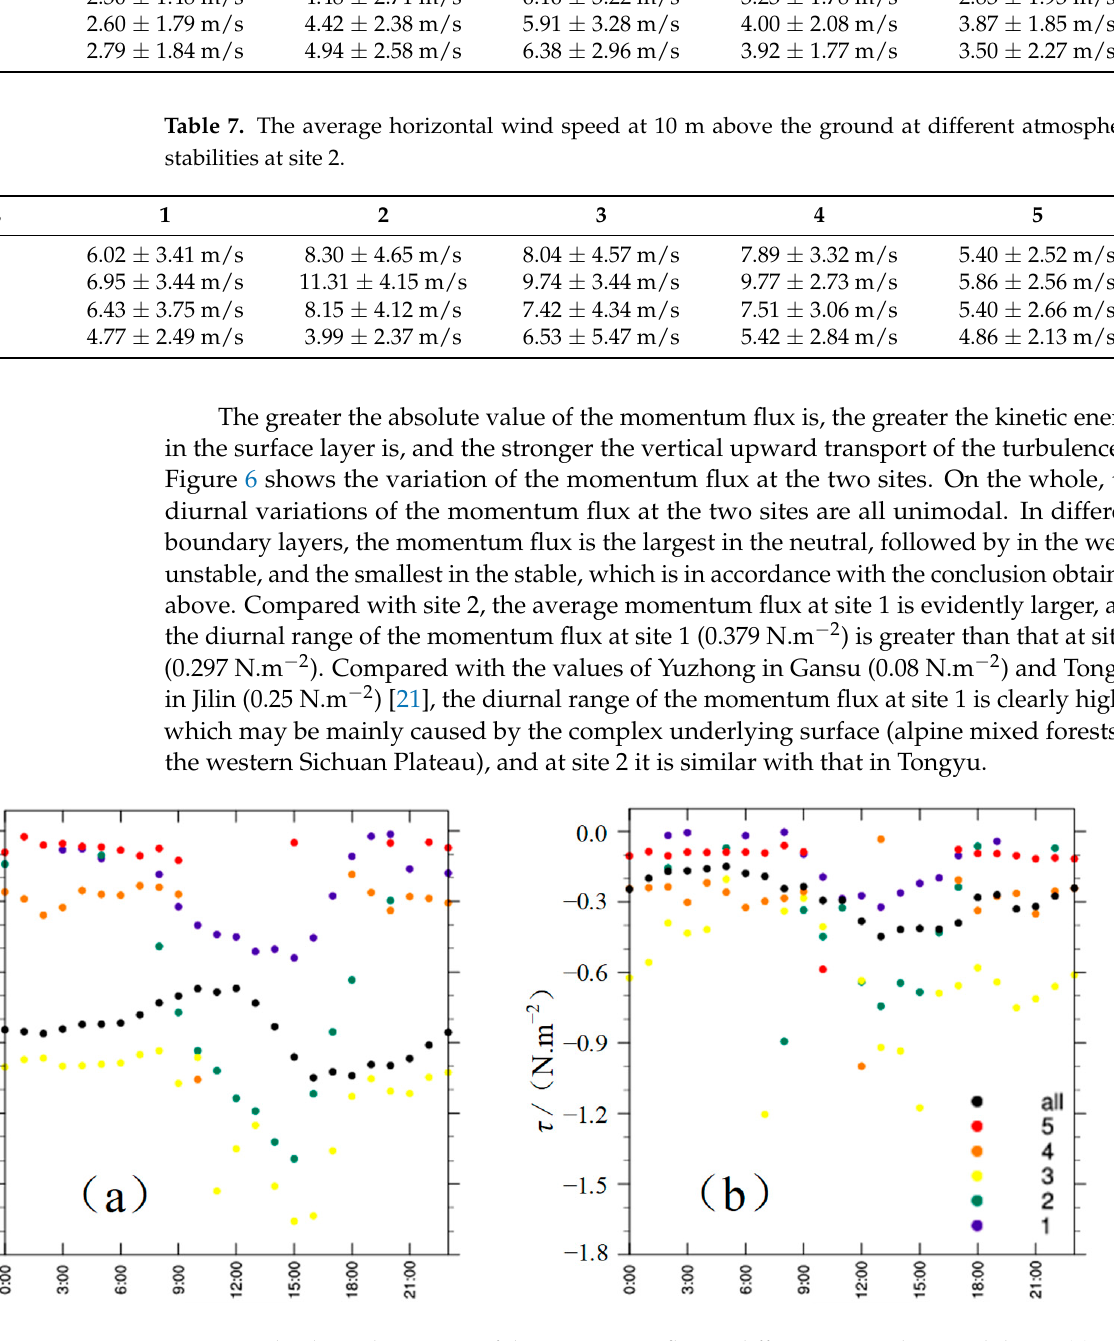
Figure 6. The diurnal variation of the momentum flux in different atmospheric stability at ( a ) site 1 and ( b ) site 2. Stability level 1: unstable; 2: weak-unstable; 3: neutral; 4: weak-stable; and 5: stable.